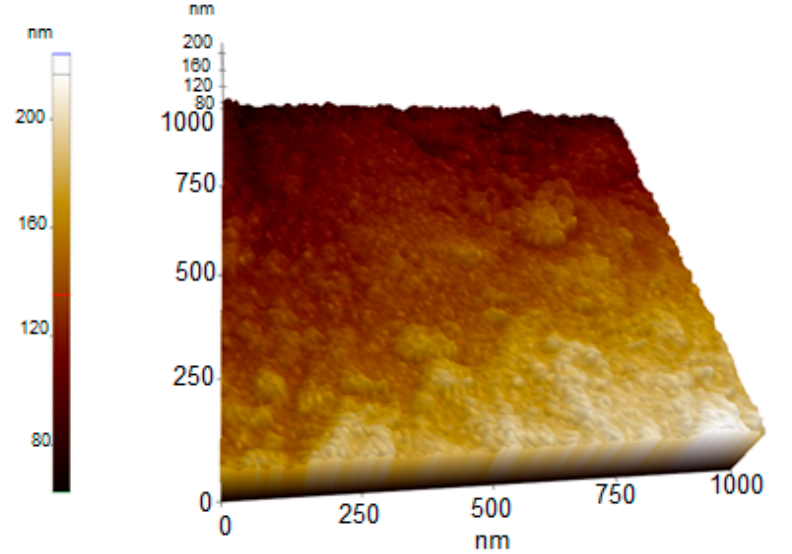
Figure 10. AFM micrograph of synthesized AC-AuNPs.